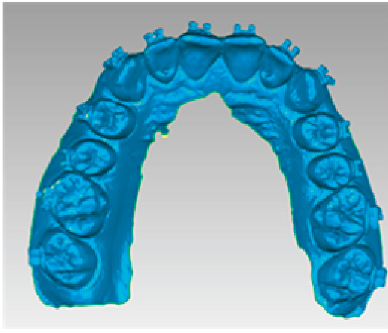
Figure 4: Preoperative model STL file.